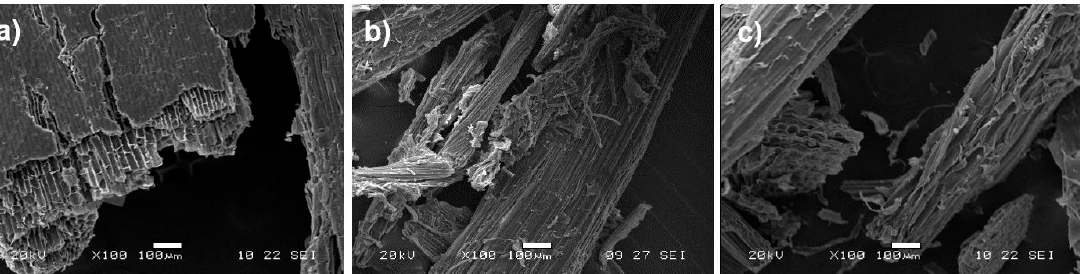
Figure 4. SEM images of the ( a ) untreated SCB fibers for a fraction superior to 315 µm; ( b ) auto- hydrolysis followed by organosolv with ethanol (AuH_EtOH) and ( c ) auto-hydrolysis (AuH_170) treated SCB fibers.